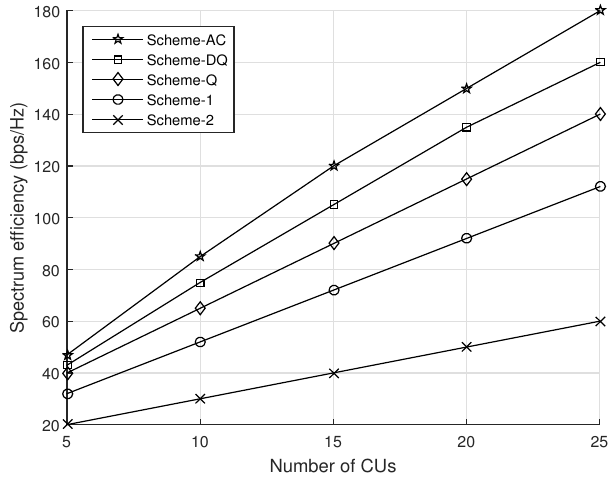
Figure 5. SE versus the number of CUs.